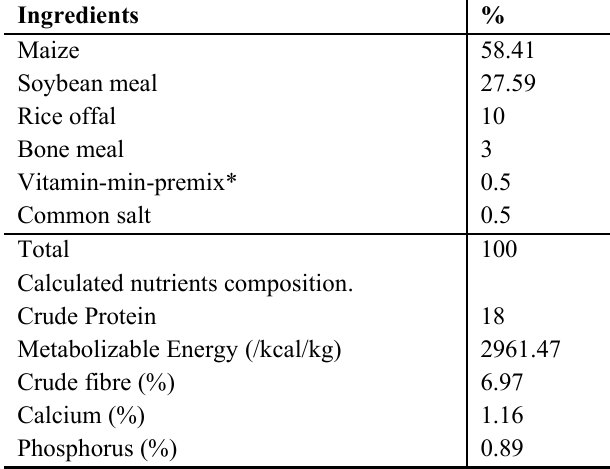
Table 1. Composition of concentrate feed and calculated values of experimental